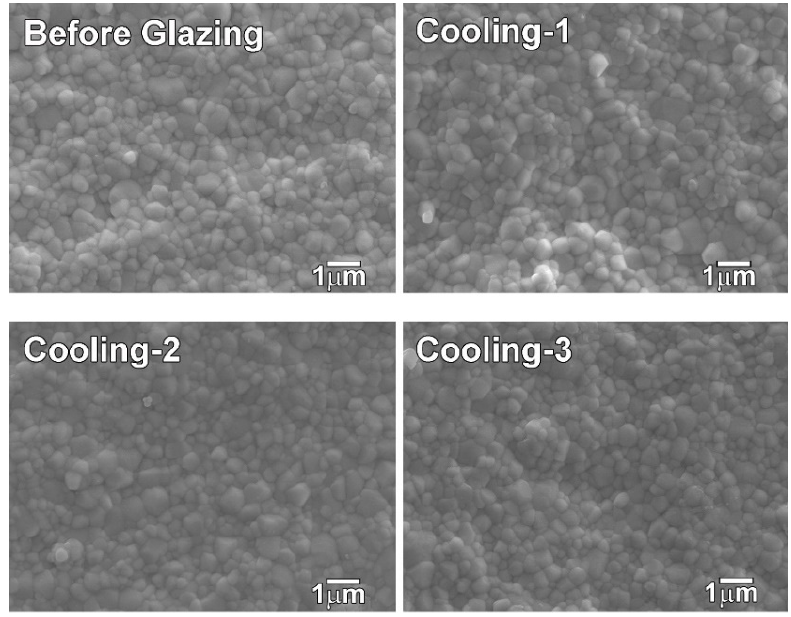
Figure 1. Microstructures of each group of zirconia specimens (×10,000).